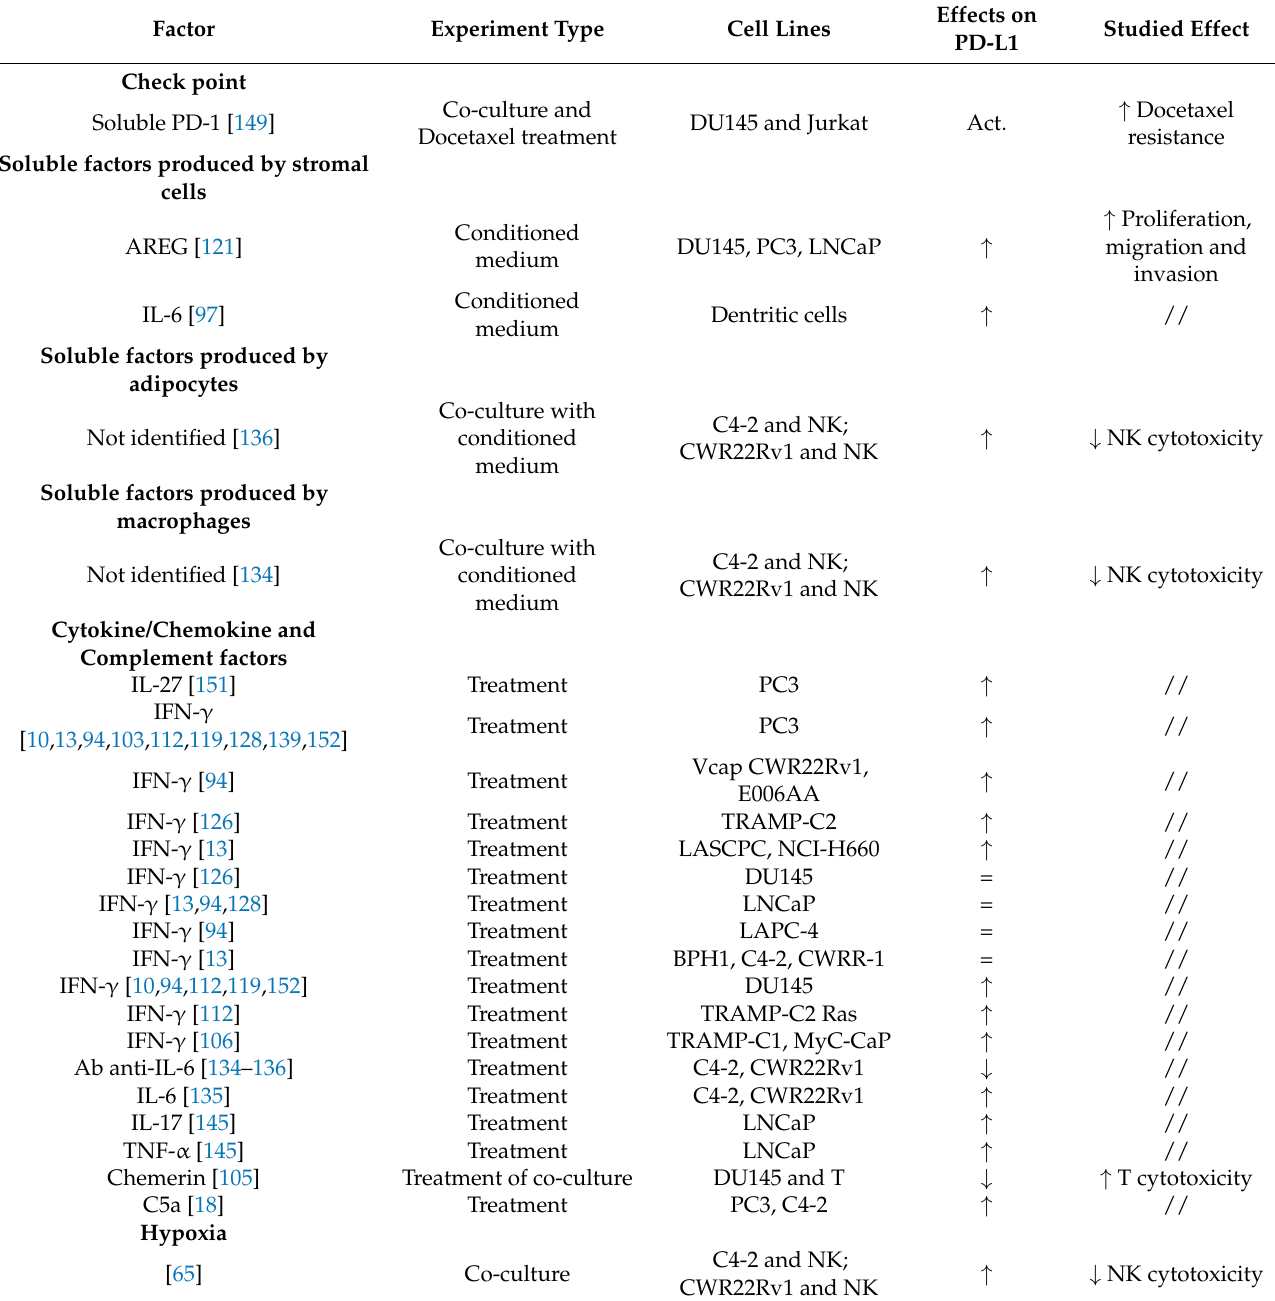
Table 1. Extracellular factors involved in the regulation of